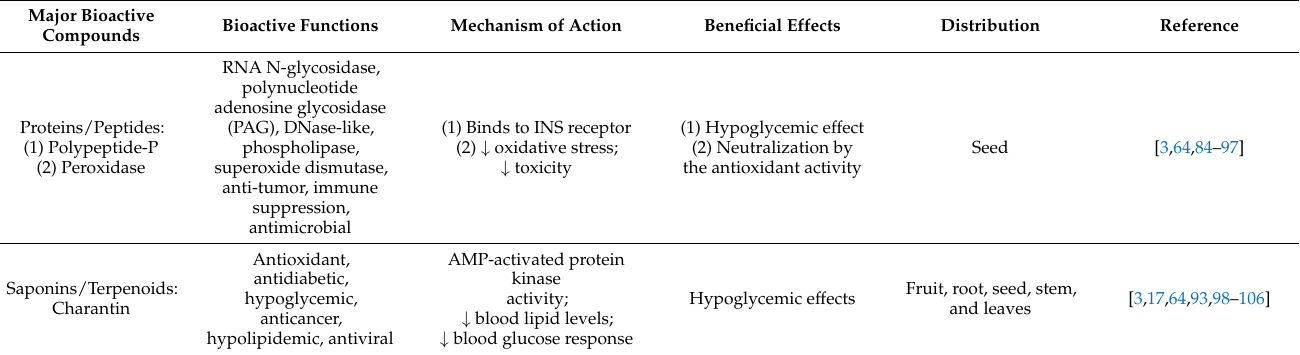
Table 2. Effects of bioactive compounds in bitter melon on AD and